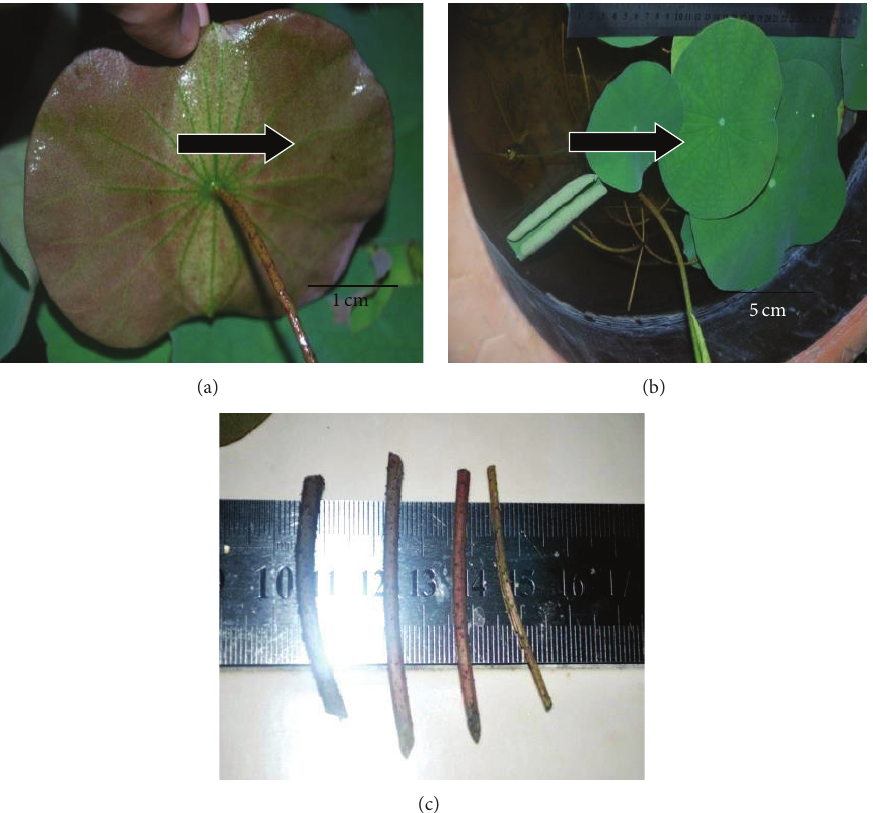
Figure 5: First 4 leaves of 8-month-old acclimatized plantlets emerged from water surface. (a) Adaxial of leaves: red spotted. (b) Abaxial of leaves: waxy green. (c) Stem: hollow and prickles (tiny torns).